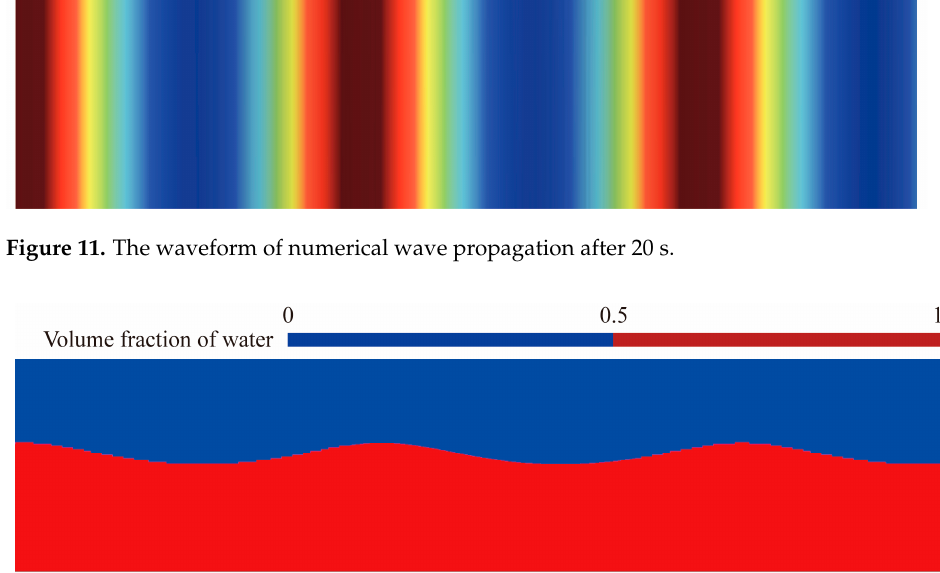
Figure 12. Distribution of water and air composition after 20 s of numerical wave propagation.